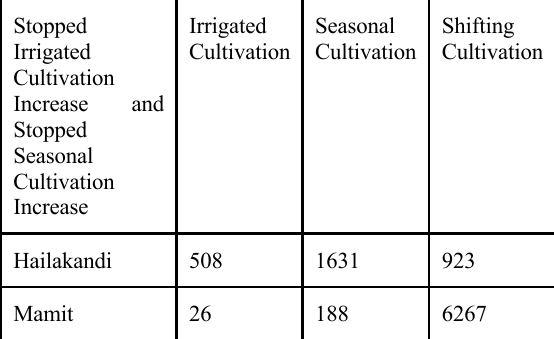
Table 7. Number of land parcels of 25 ha each under various forms of land use in the stopped irrigated cultivation increase and stopped seasonal cultivation increase scenario for the year 2035